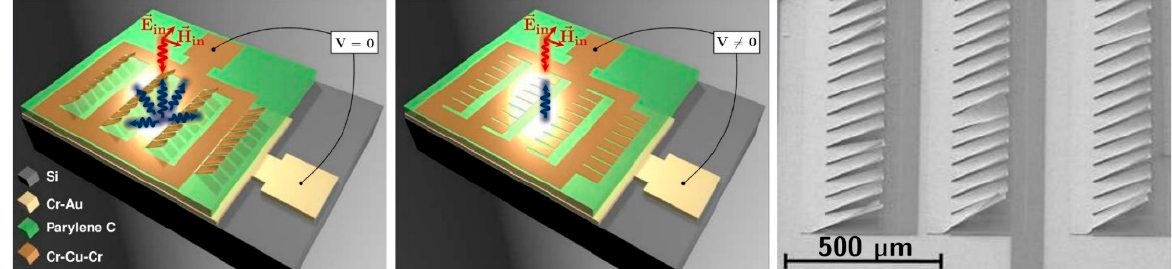
Figure 2. THz micromirror SLM based on self-assembled metal multilayer structure. Reproduced with permission from [44]. Copyright 2019 Springer Nature.